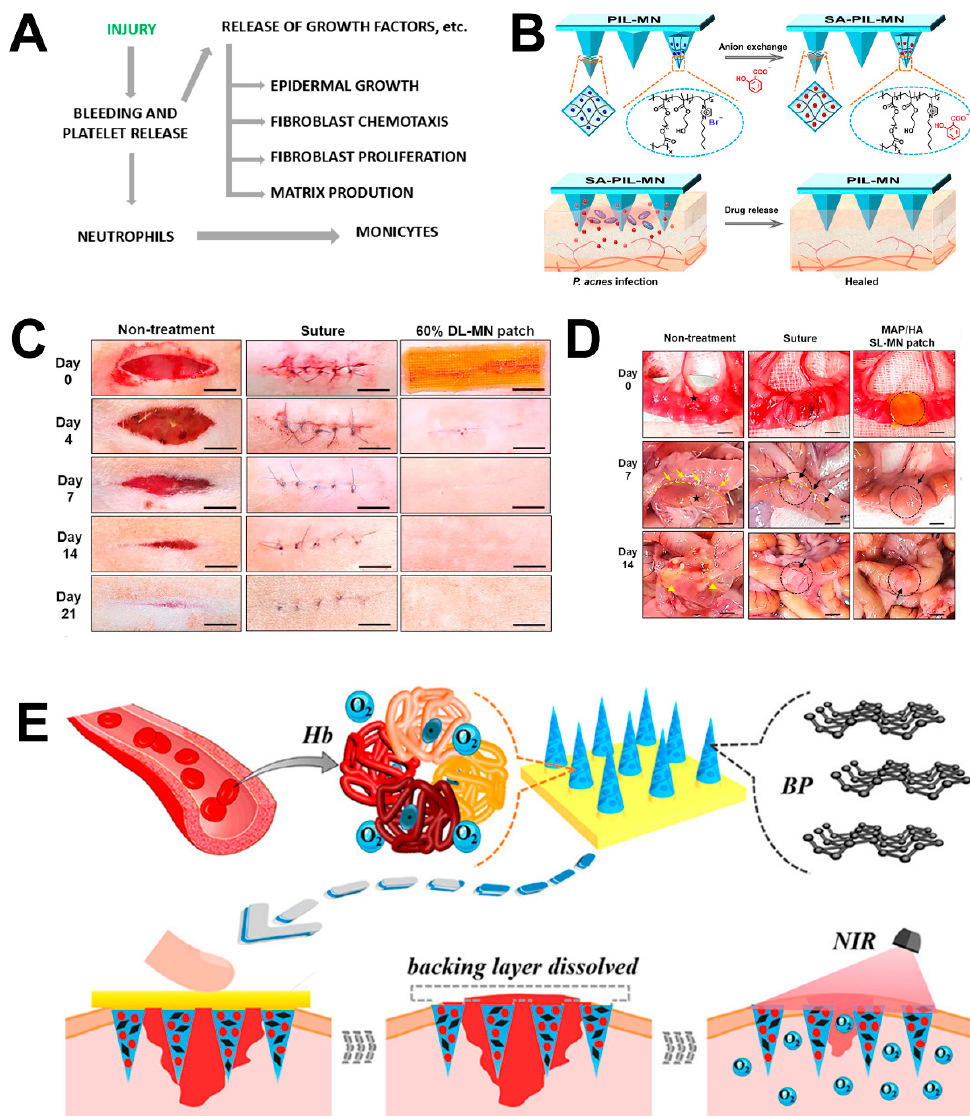
Figure 9. Schematic diagram of the principle and the wounds by microneedle therapy. ( A ) Inflammatory responses after microneedle was applied to the skin. ( B ) Release of SA from SA-IL-MNs. ( C , D ) Macroscopic images of skin or ileum wounds in DL-MN (double-layer-MN) treated rats. ( E ) Schematic diagram of the BP-loaded, oxygen-carrying responsive MNs in wound healing. (Images were reproduced with permission from [15,77,86,87]).